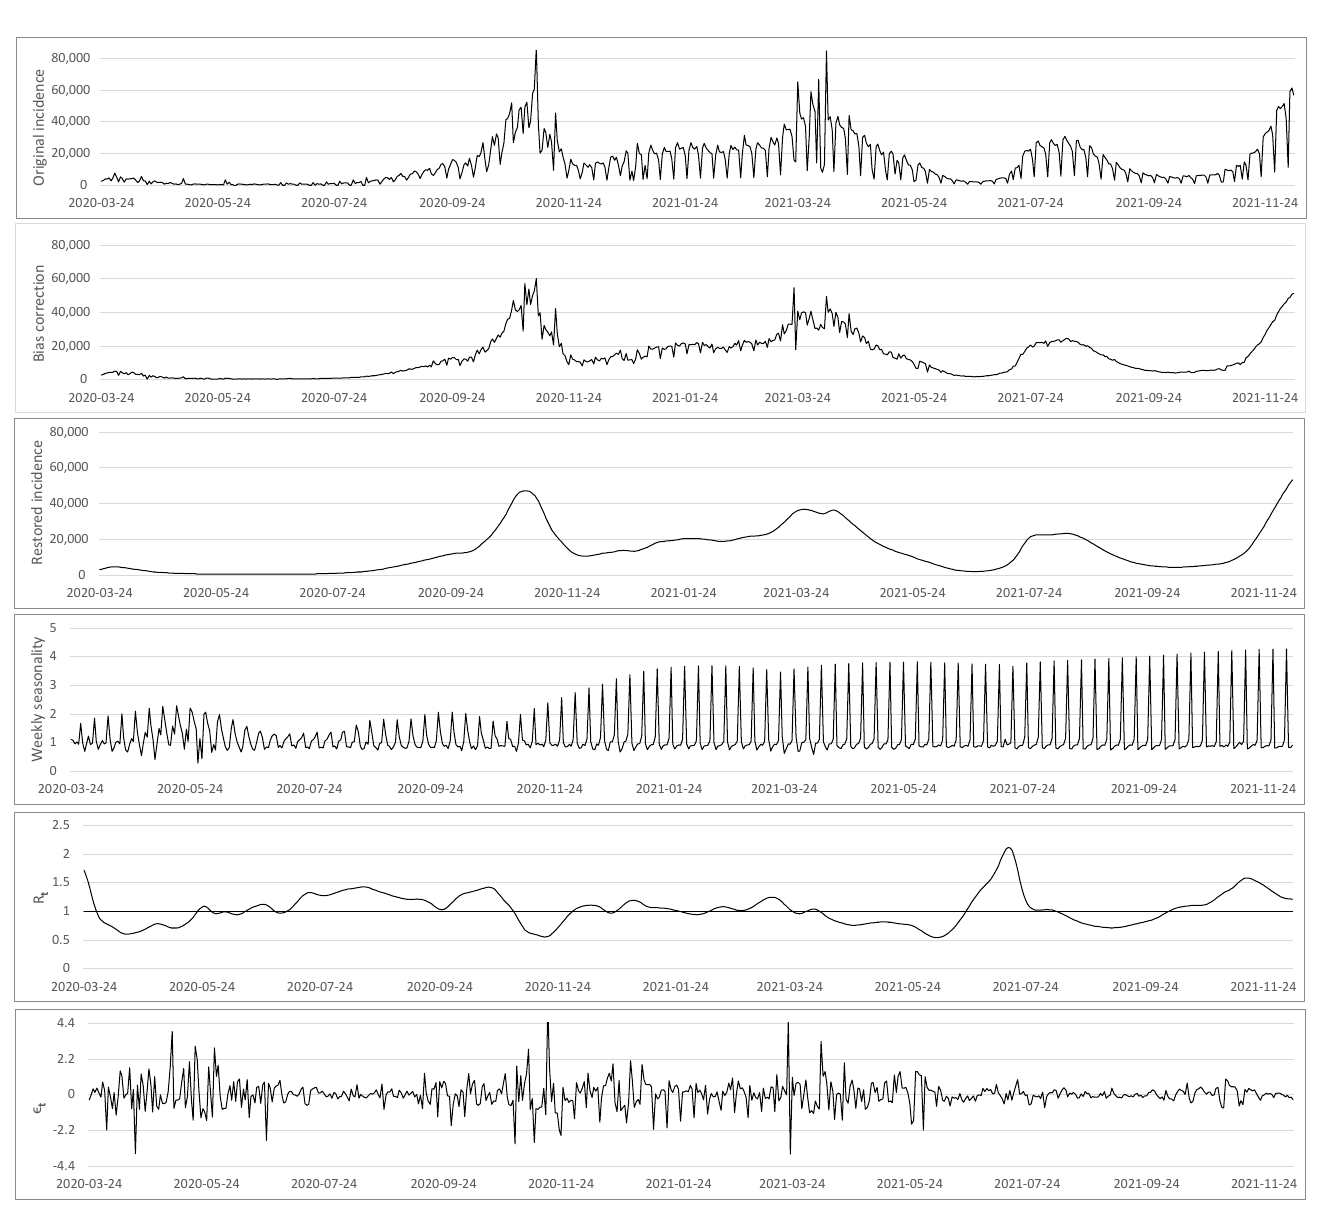
Figure 4. From top to bottom: (i) the original incidence curve i 0 after bias correction ˆ i t , (iii) the restored incidence curve using the renewal equation i r bias correction factors q t , (v) the reproduction number estimation R t and (vi) the normalized error − ˆ i t ) / ( i r ) a , where a is the optimal exponent obtained by regression (see Table ε t = ( i r t t